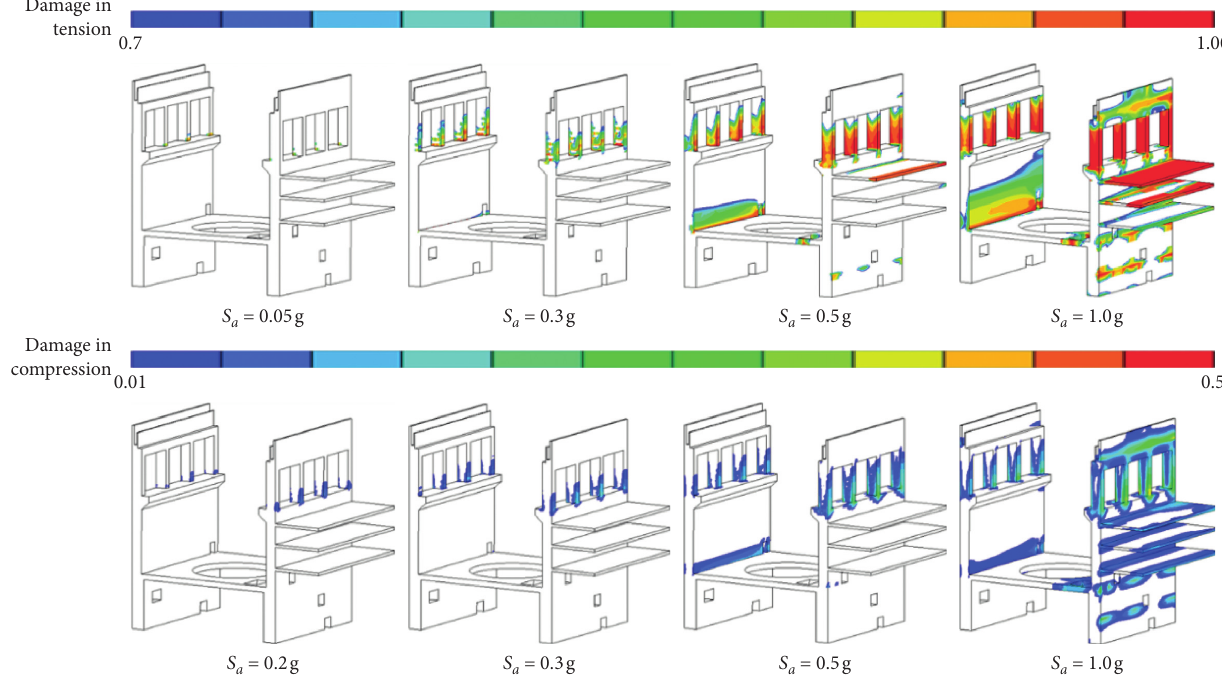
Figure 10: Ultimate damage profiles of RCF-SW structure under Koyna